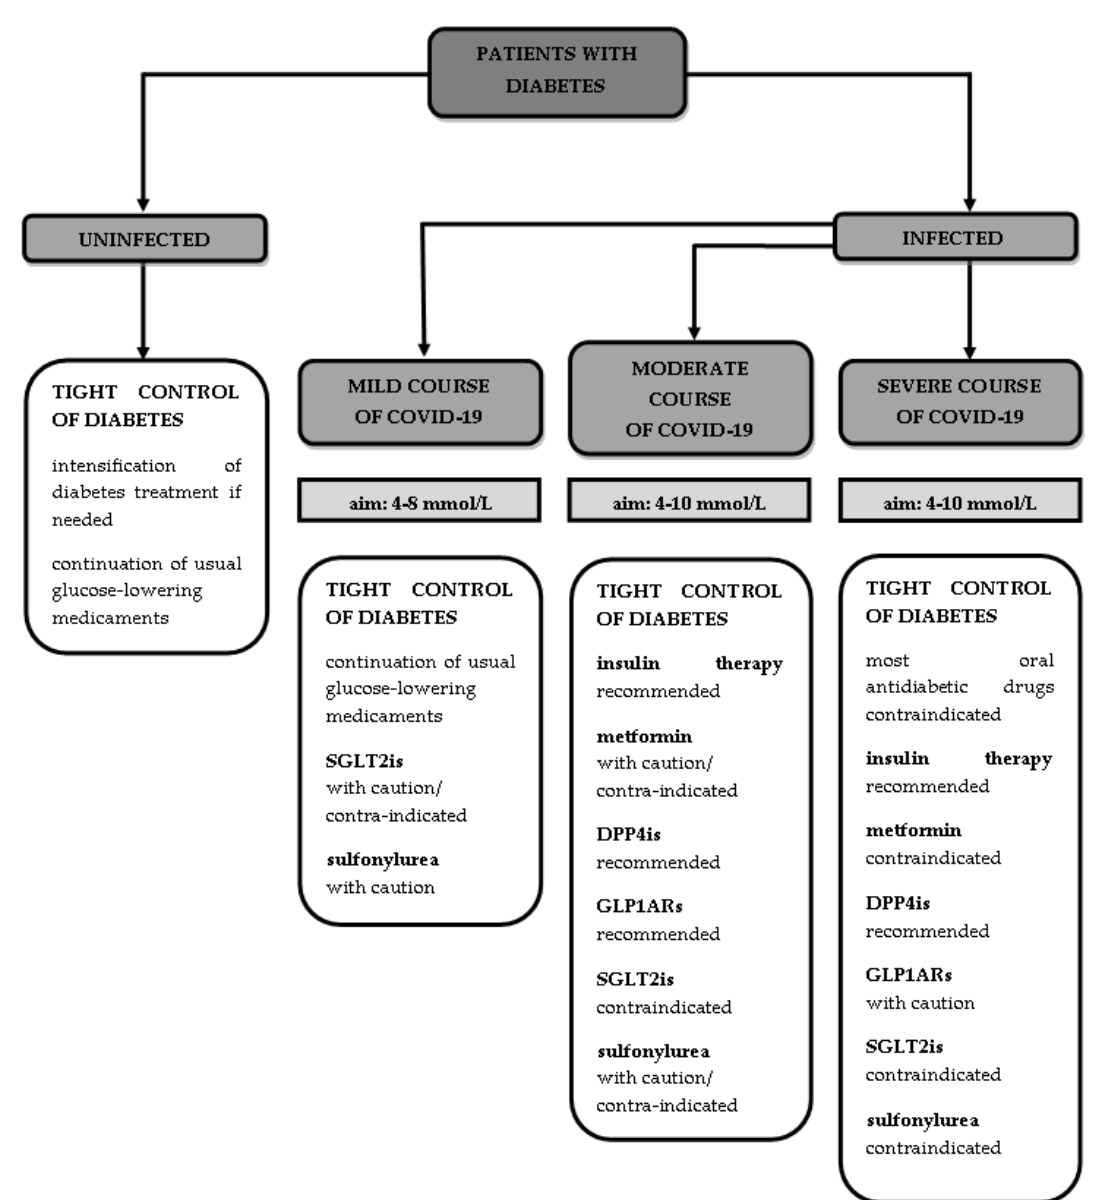
Figure 2. Recommendations pertaining to diabetes treatment during COVID-19 pandemic.